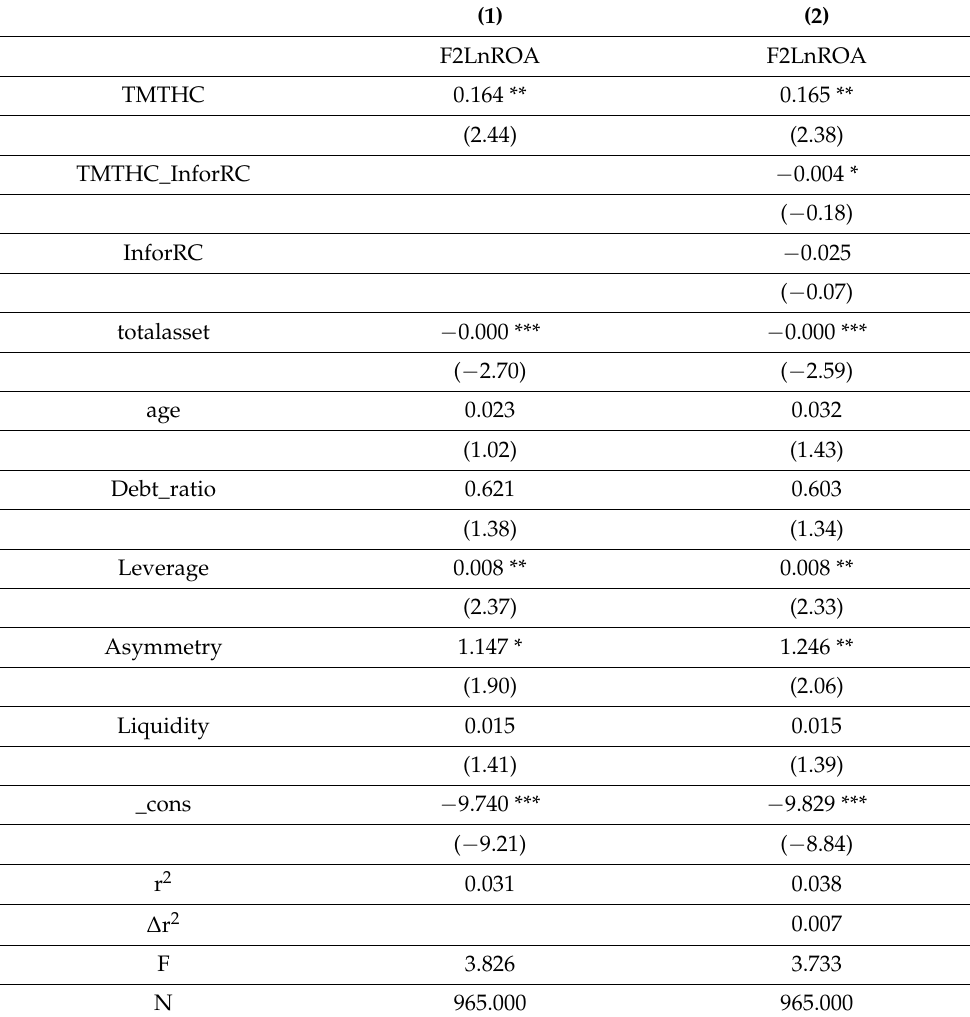
Table A3. Results of the panel regression with fixed effects (firm and year).